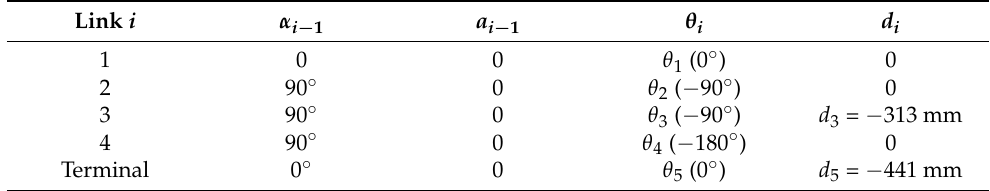
Table 1. The parameter list of